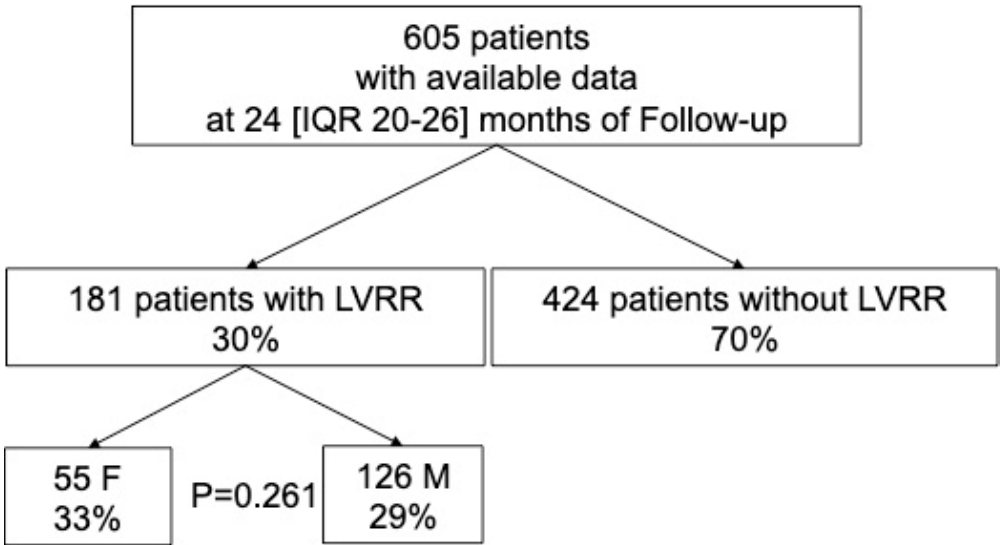
Figure 1. Diagram of study population. Legend. F: Females; LVRR: Left Ventricular Reverse Remodelling; M: Males. Table 1. Characteristics of the Population at 24-month evaluation.